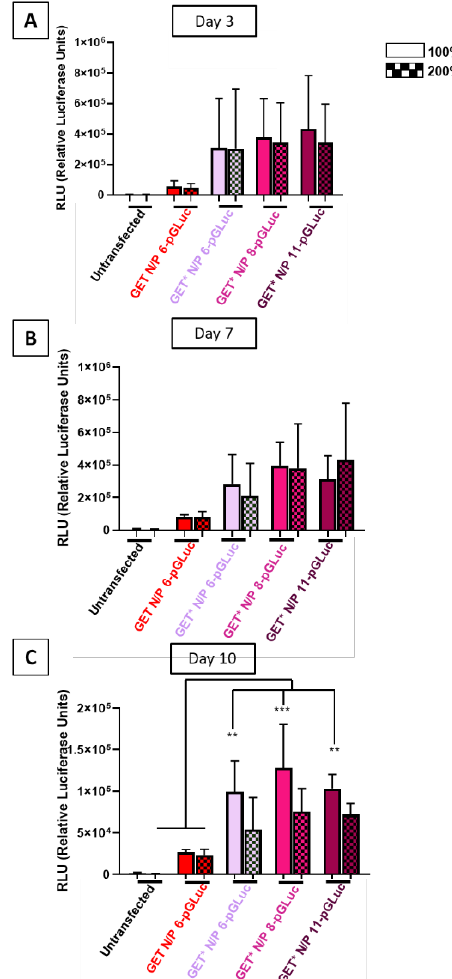
Figure 5. Transfection efficiency increased marginally in GET*-transfected cells, but not significantly at ( A ) day 3 or ( B ) day 7 post-transfection. ( C ) Transfection efficiency was significantly higher in GET* N/P 8-transfected MSCs on 100% wt. coll–nHA scaffolds at day 10 post-transfection ( p < 0.01 **, p < 0.001 ***). Error bars represent ± SD, n = 3 tested in triplicate.